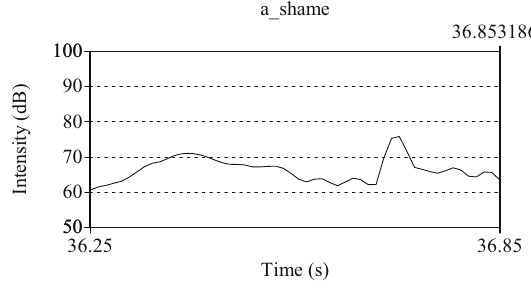
Figure 8: Audible outbreath with intensity of 76 dB.